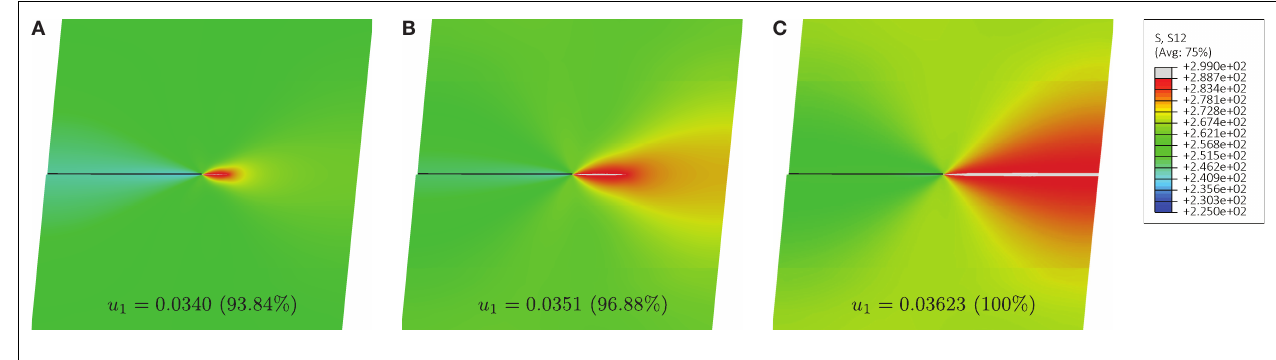
prescribed displacement at the upper edge of the square domain u 1 = 0.0340mm (A) , u 1 = 0.0351mm (B) , u 1 = 0.03623mm (C) .The √ 3.Three displacements in the figures are amplified by a deformation scale factor of 27.